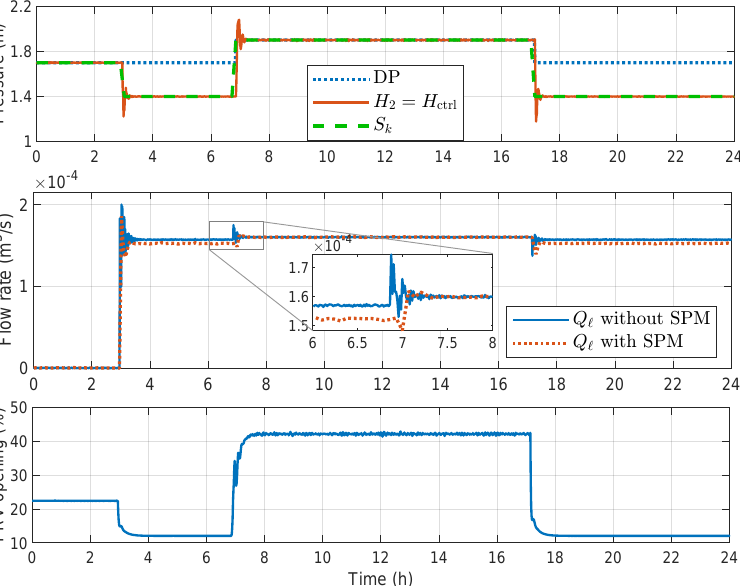
Figure 10. Case 3: Pressure control and management in a branched water distribution network.